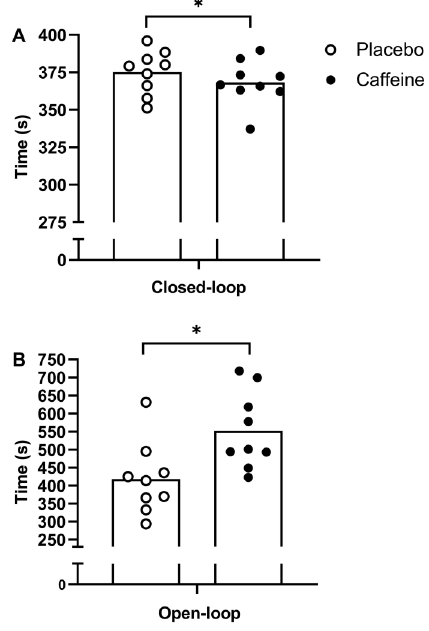
Figure 1. Time to complete 4,000 m cycling time trial (closed-loop exercise) ( A ) and time to task failure (open-loop exercise) ( B ). Data are reported as means ± SD. *P o 0.05 (paired t -test).